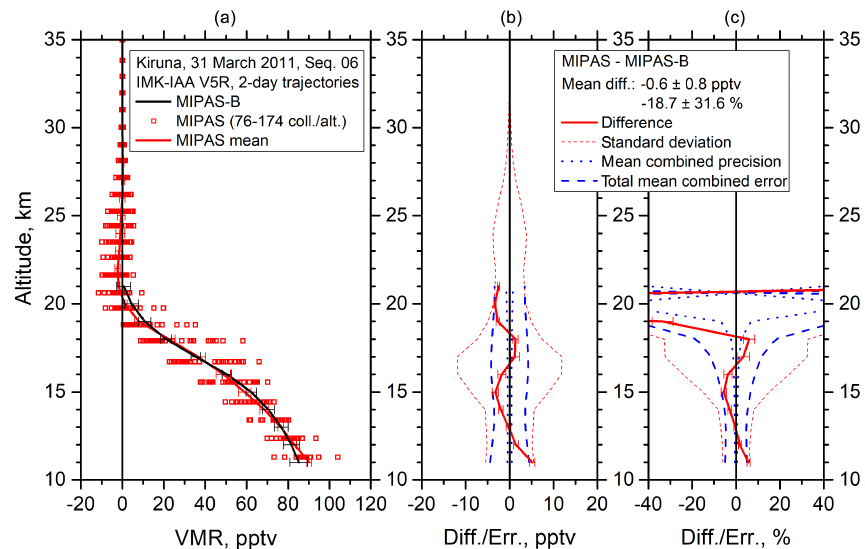
Figure 15. Comparison of MIPAS Envisat and MIPAS-B2 CCl 4 for the MIPAS-B2 flight on 31 March 2011 over Kiruna, Sweden. (a) Mean profile of all coincident profiles (black line: MIPAS-B2; red line: MIPAS mean; red squares: coincident MIPAS measurements). (b) Absolute total error budget without consideration of the spectroscopy error. (c) Relative error budget − red continuous line: difference between the mean profiles; red dotted line: standard deviation; blue dotted line: mean combined precision; blue dashed line: total mean combined